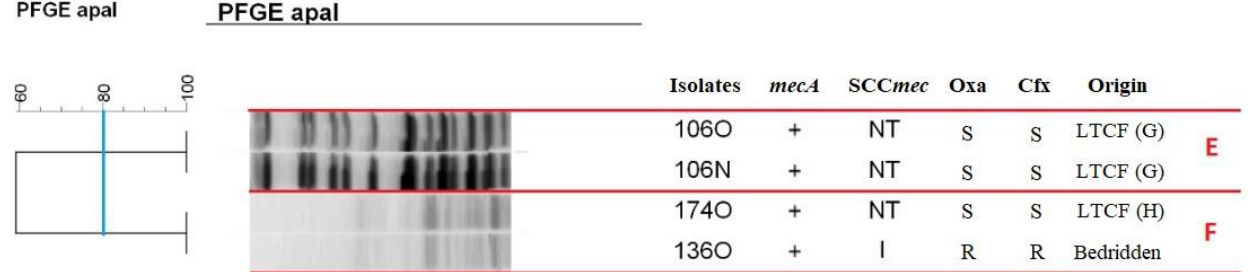
Figure 3. Dendrogram of PFGE-ApaI profiles of MRSA isolated from bedridden patients at home or